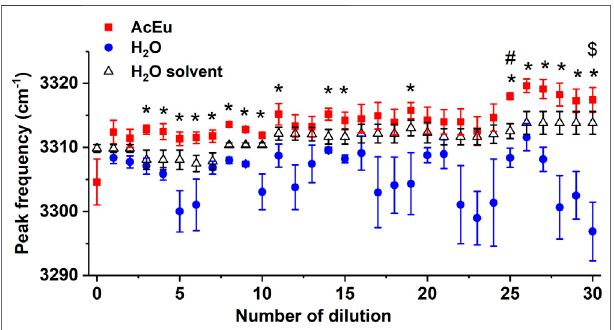
FIGURE 3 | Dependence of the position of the IR band maximum of the OH groups ’ stretching vibrations on the number of dilutions of the initial AcEu solution and water. Daily water monitoring is also shown. * — statistically signi fi cantdifferencebetweentheAcEudilutionandtherespectivewater dilution, # — statistically signi fi cant difference between the AcEu dilution and water,$ — statisticallysigni fi cantdifferencebetweenwaterdilutionandwater. The data are presented as mean ± se.